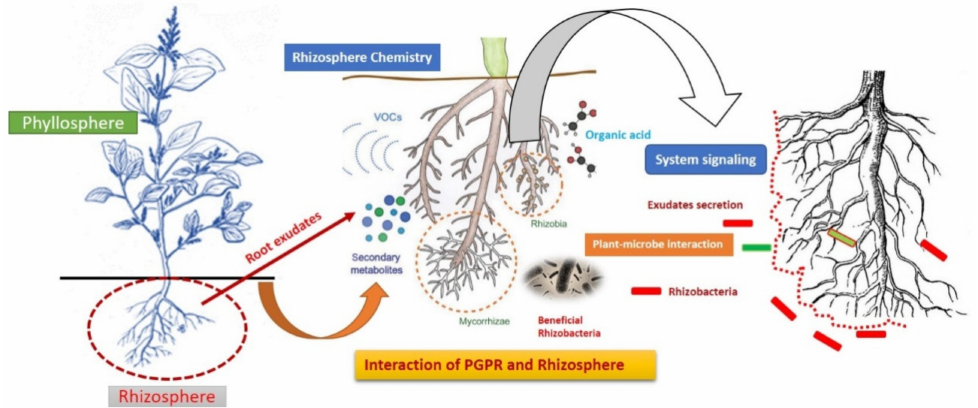
Figure 1. Plant-microbes interactions in the rhizosphere (a hotbed for interlinked microbes and plant root zone) mediated by system signaling, exudates secretion, and colonization potentiality are directly and indirectly improve plant growth and stress